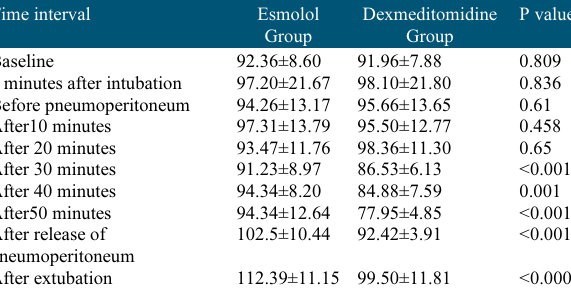
Table 3: Mean arterial pressure (MAP)